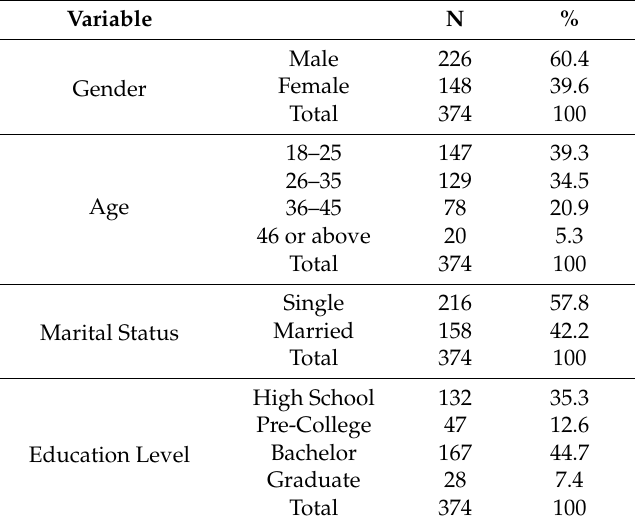
Table 1. Demographic profile of respondents.